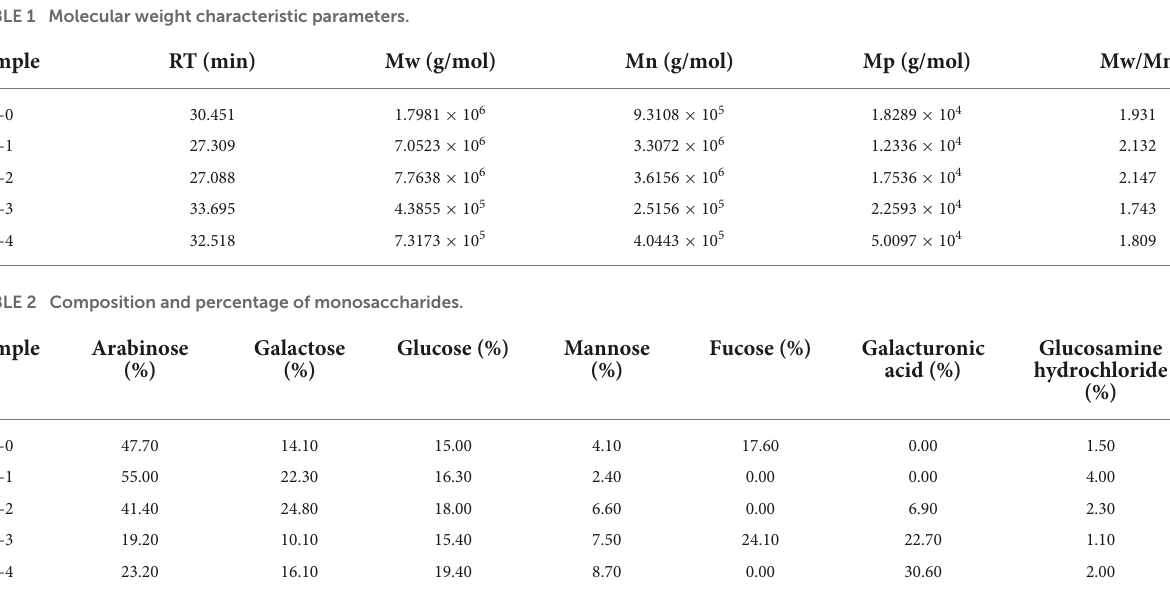
TABLE 1 Molecular weight characteristic parameters.